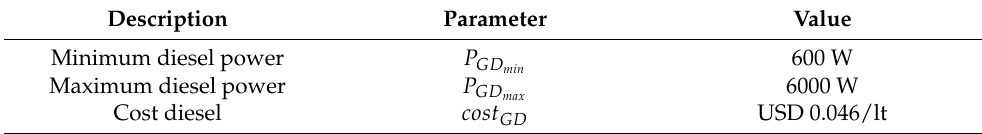
Table 3. Characteristics of the Diesel Generator.